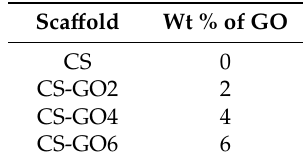
Table 2. GTA crosslinked CS sca ff olds with di ff erent wt % of